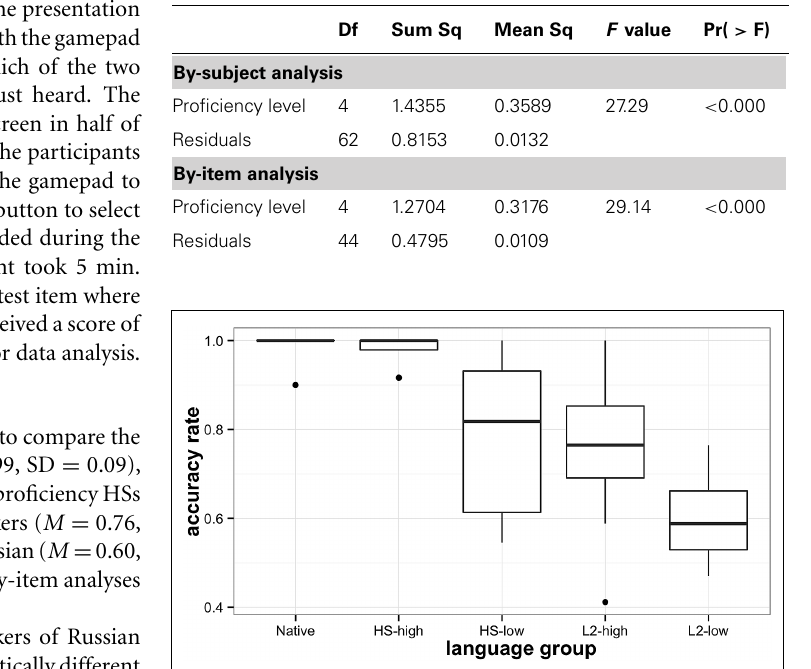
FIGURE 4 | Heritage, L2, and native participants’ accuracy scores on picture-word discrimination